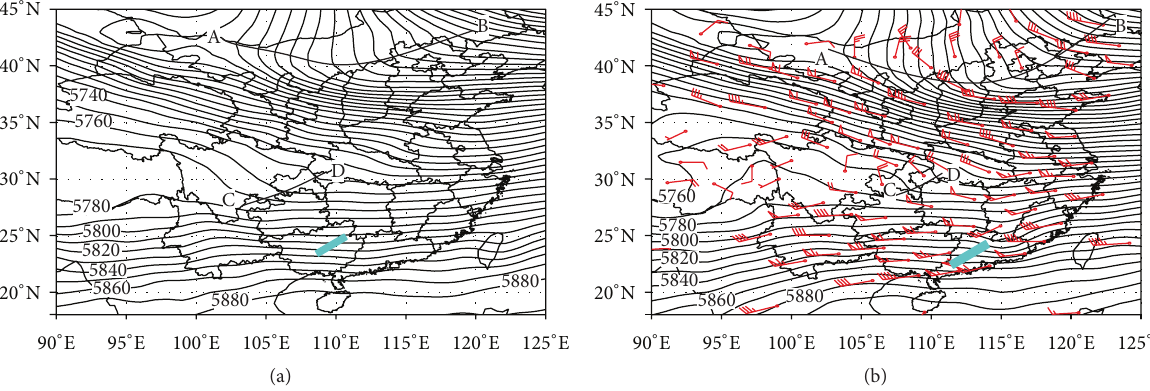
Figure 2: National Centers for Environment Prediction (NCEP) geopotential height analyses at 500 hPa from 0200 LST (a) and 0800 LST (b) 24 April 2007. The blue rectangles indicate the position of the squall line and the thick solid lines are for the trough.